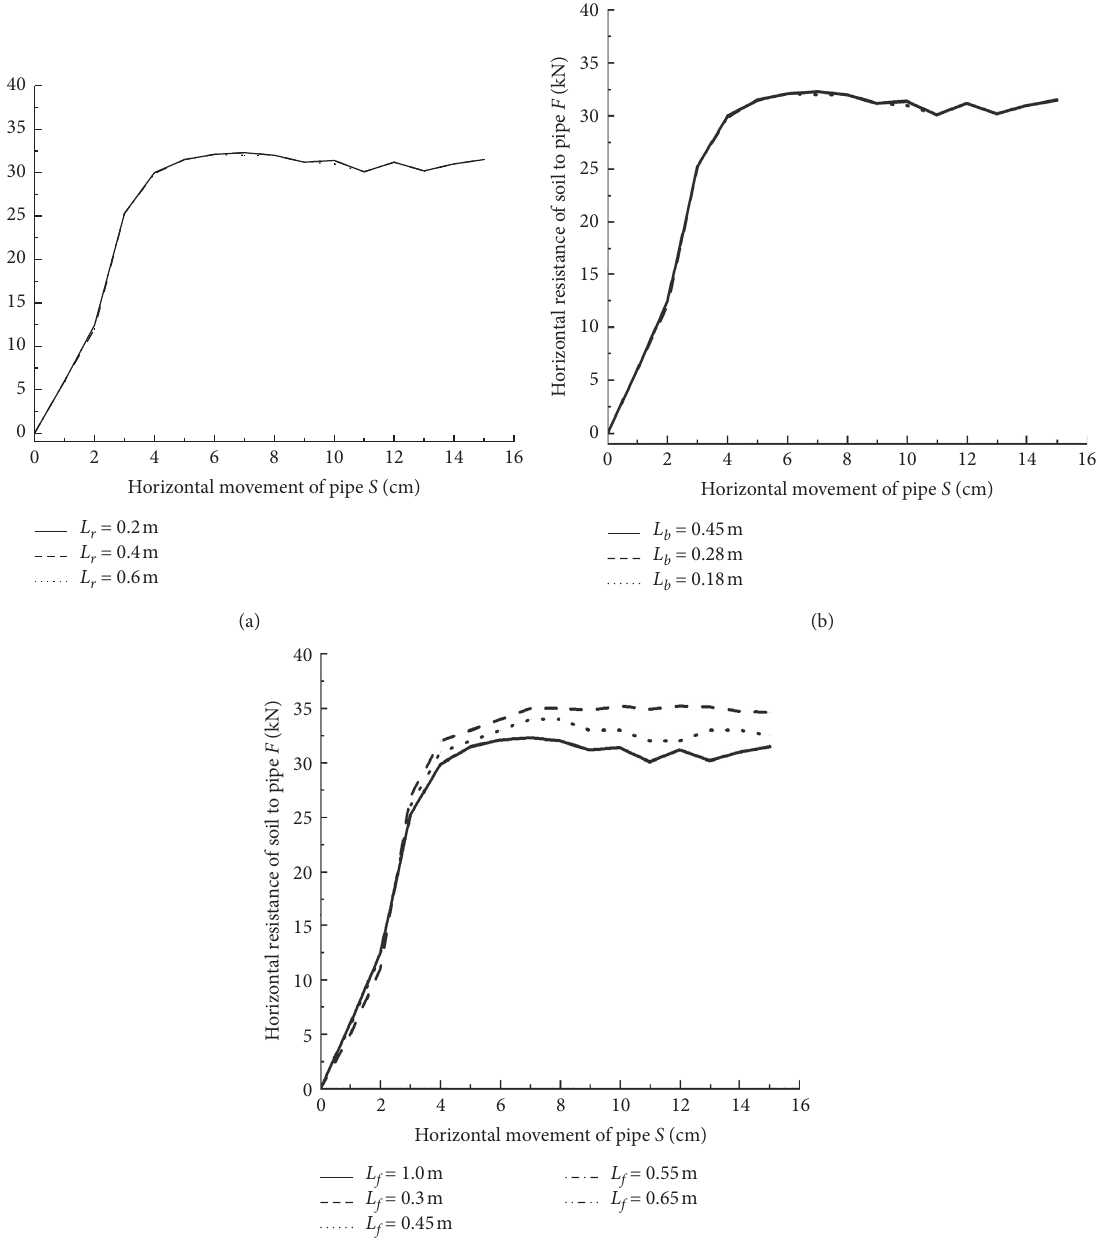
Figure 8: Resistance displacement curves under different boundary distances, in which the diameter of tube is 60mm, the depth diameter ratio H / D equals 5, the dry unit weight of soil is 16kN/m 3 , and the moisture content of soil is 16%. (a) The rear boundary. (b) The bottom boundary. (c) The front